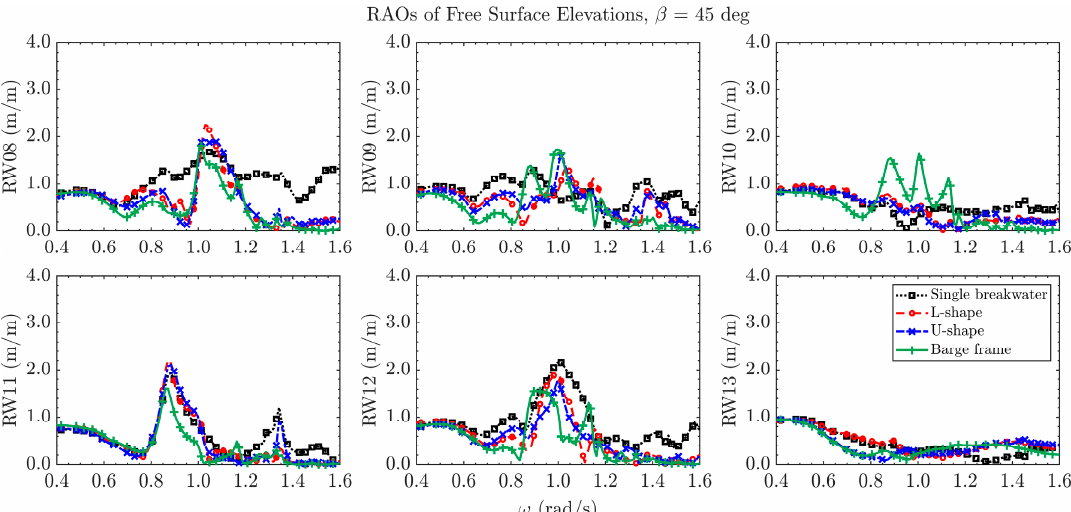
Figure 17. Motion RAOs of free surface elevations around the floating tanks with the different configurations of floating breakwaters in 45 deg wave direction.